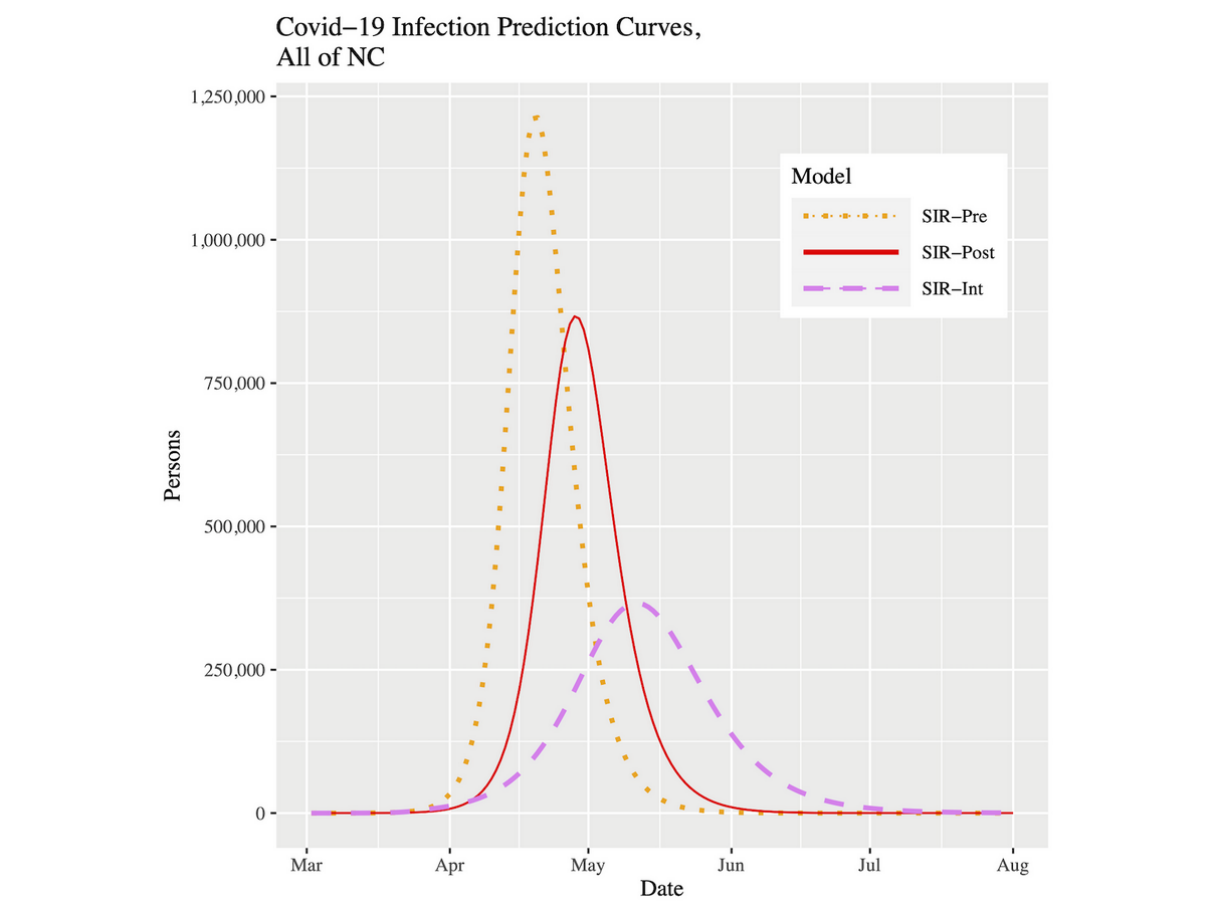
Figure 7. Infection prevalence prediction curves for NC up to August 1, 2020. COVID-19: coronavirus disease; NC: North Carolina; SIR: